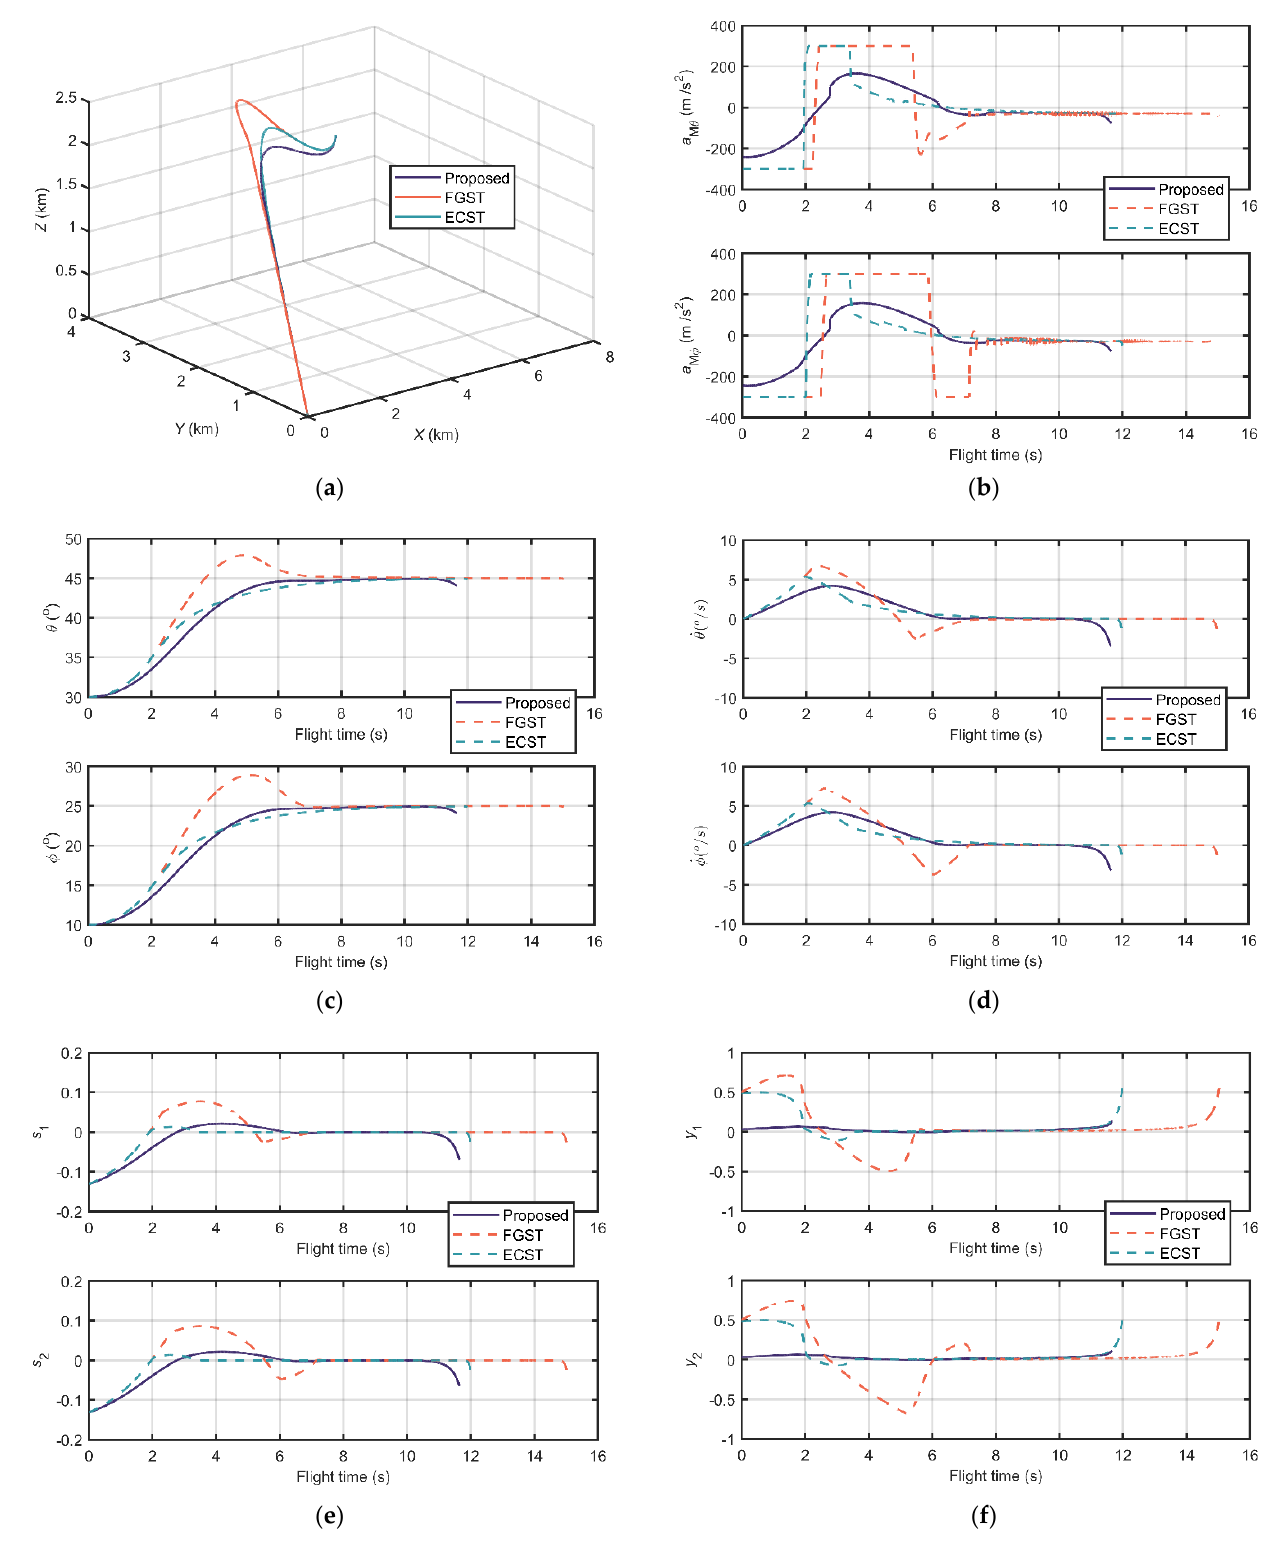
Figure 7. Comparison results of case 2: ( a ) Relative distance trajectories; ( b ) Acceleration commands; ( c ) LOS angles; ( d ) LOS angular rates; ( e ) The sliding manifold; and ( f ) The state variable y ( t ) Furthermore, the detailed information of the two cases is listed in Tables 2 and 3, respectively. It can be obviously seen that the flight time of missiles utilizing the proposed